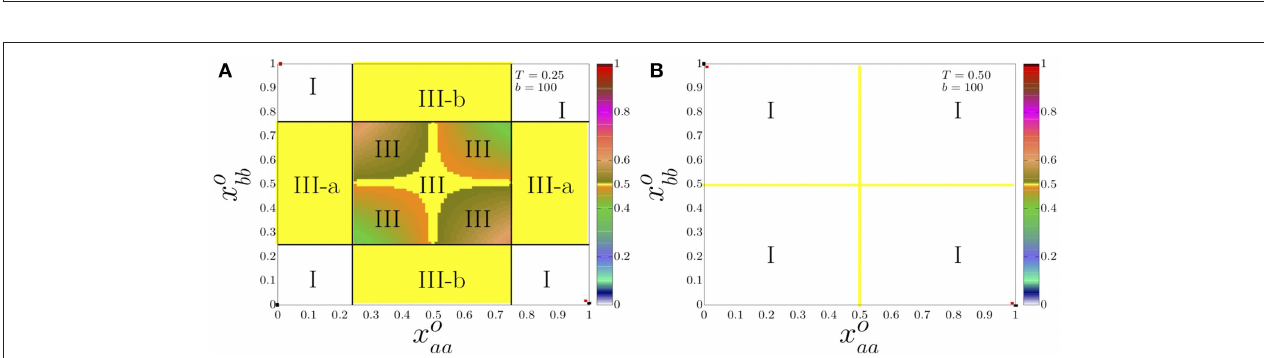
FIGURE 8 | Sizes of the basins of attraction of chimera states categorized by Q 1 and Q 2 , denoted by A Q as function of b for different values of T (C,D) .